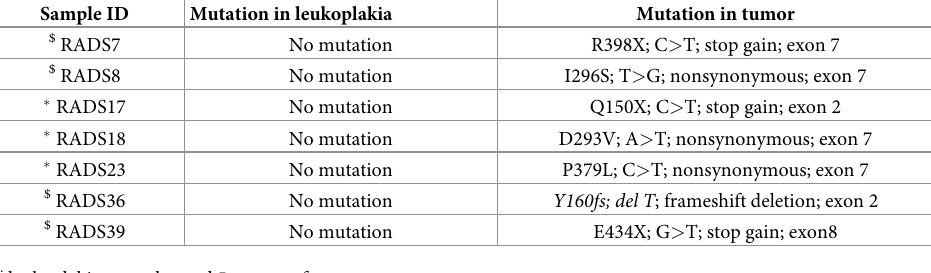
Table 3. Presence of mutation in CASP8 in cancer but not in adjacent leukoplakia tissues from same patients (n = 7).